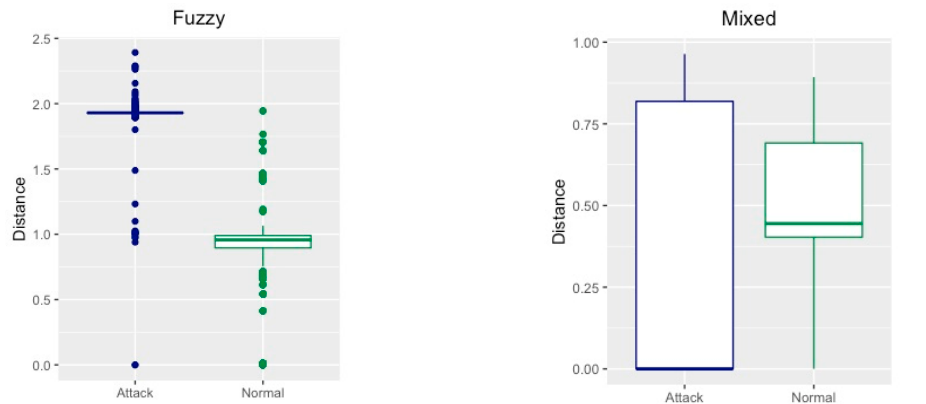
Figure 10. Distances between the input vectors and the winning neurons for the XYF network on the 8 × 8 neurons map. Table 6. Distances between the input vectors and the winning neurons metrics in the XYF network.